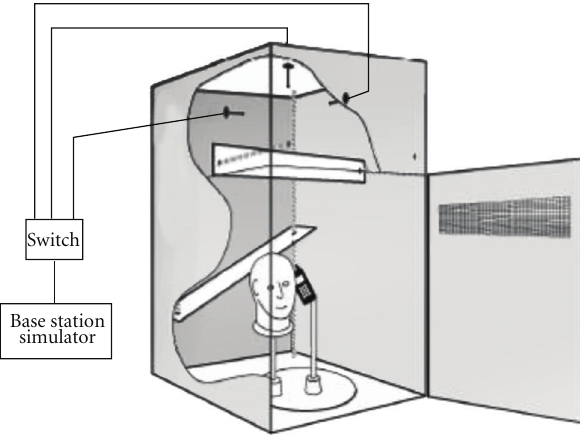
Figure 6: Reverberation chamber setup for devices testing with single cavity (TR 37.976 [7] Figure 6 . 3 . 2 . 1-1).